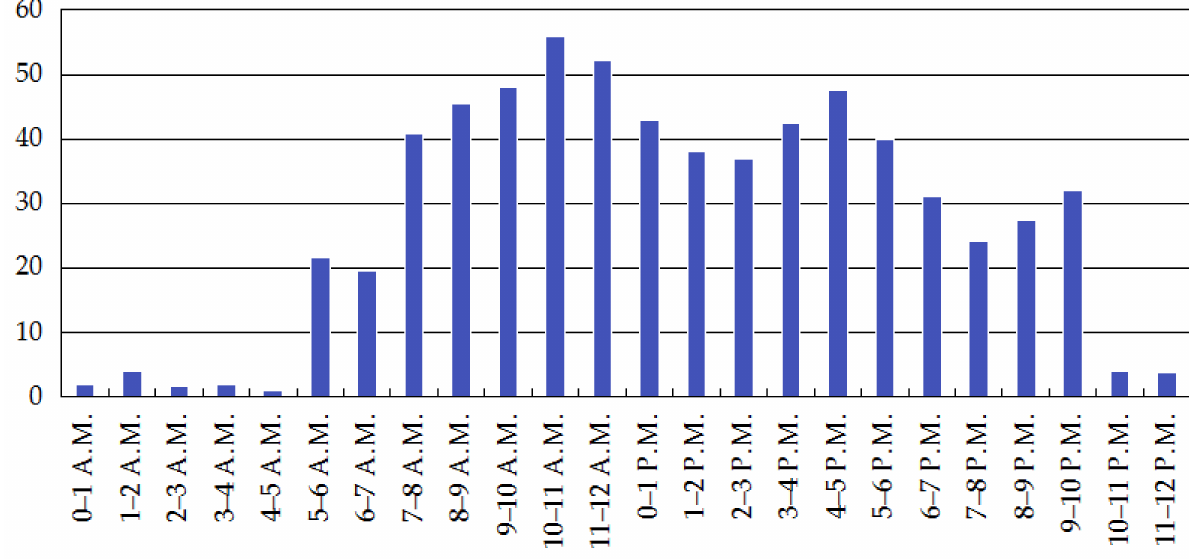
Figure 3. For each time interval (local time), the percentage of time that the tracked red-footed falcons were in flight is shown.